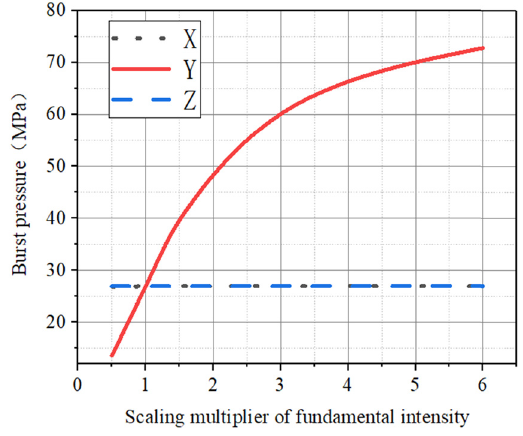
Figure 6: E ff ect of fundamental strengths on the burst